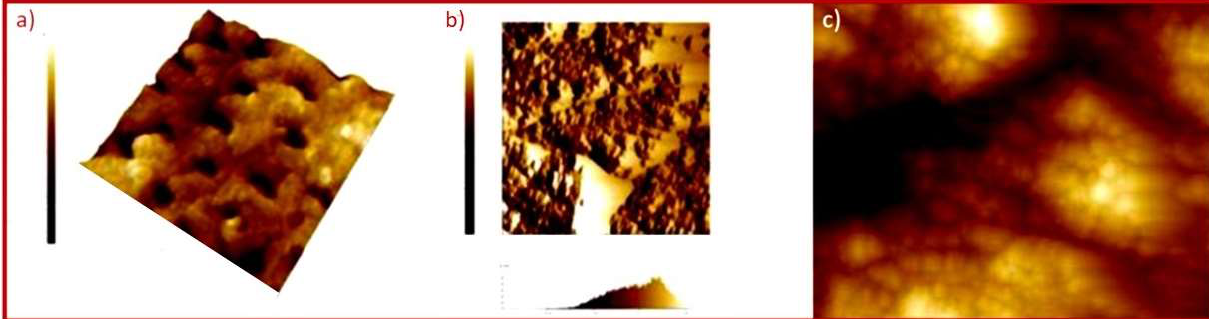
Figure 18. Microscopic surface map showing the image of the specimen surface in an atomic force microscope ( a ) with visible tubules and a visible connection in the dentin tubule with the filling (gutta-percha as a filling material using the thermoplastic method or sealant) (4000×); ( b ) with an indication of height differences and a histogram distribution of the height of the eminence and depressions of the surface after filling the root canal using the cold side condensation method with filling material based on polymeric polyester Resilon-type materials (4000×); ( c ) with visible elevations and depres- sions related to leaks, with the filling material and obturation method as in ( a ) (8000×).